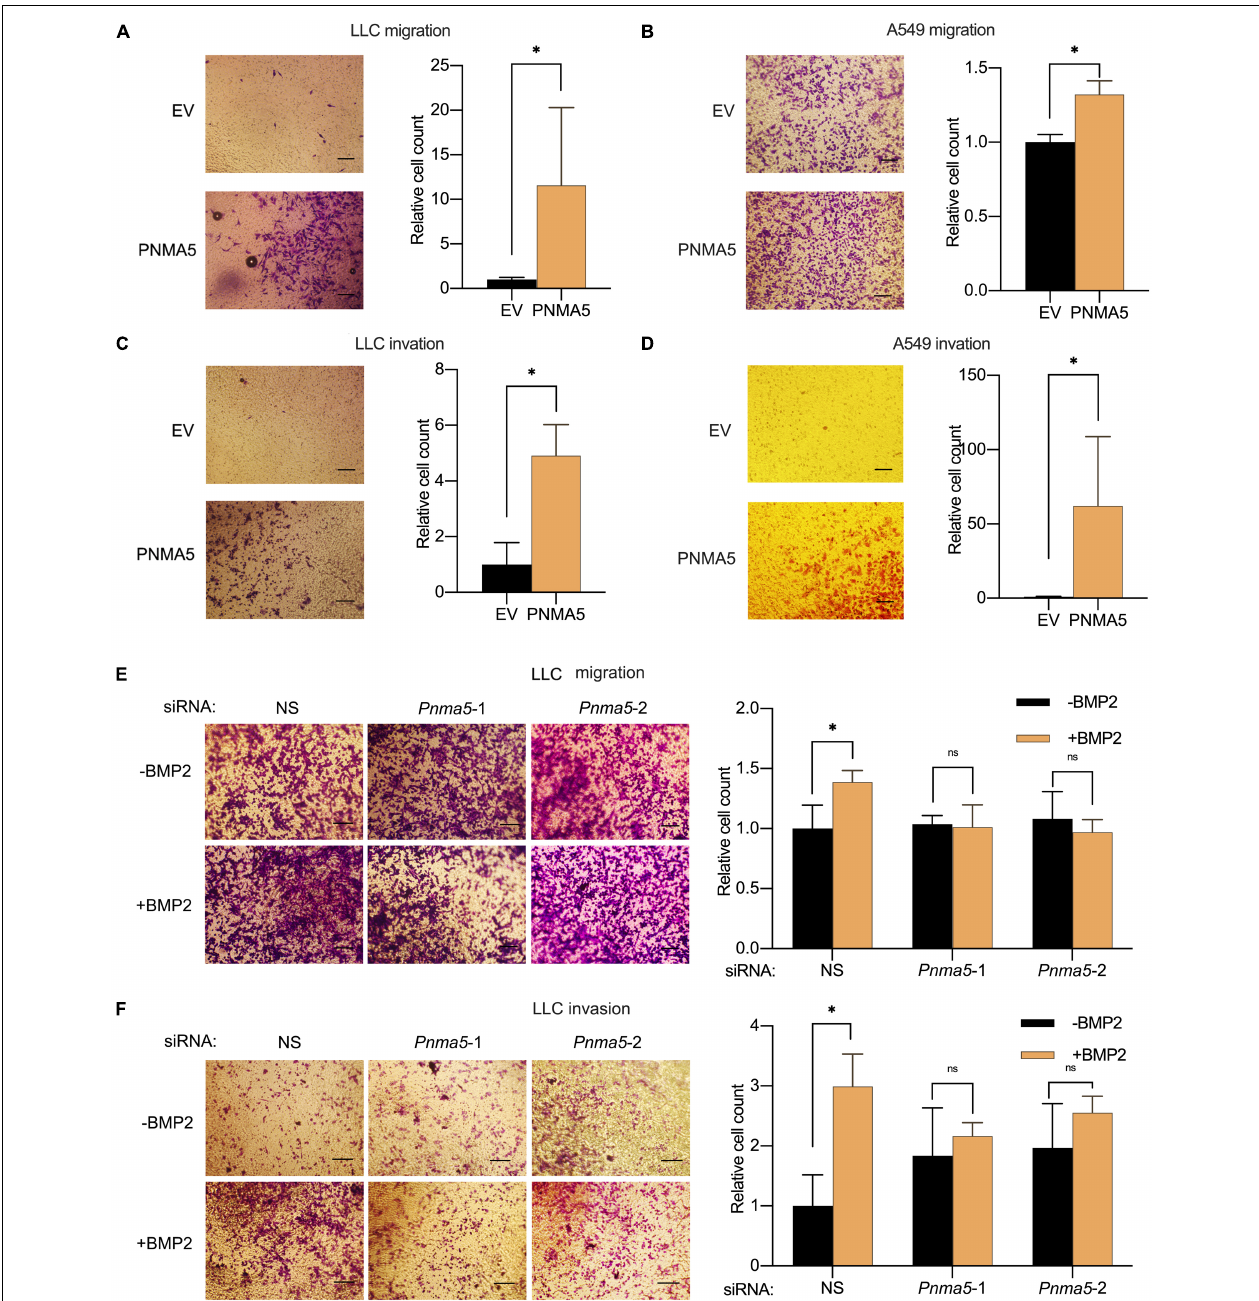
FIGURE 4 | BMP2 signaling induced the migration and invasion of NSCLC cells via PNMA5. (A,B) The 1 × 10 4 empty vector (EV) and PNMA5 overexpressed LLC (A) or A549 (B) cells were seeded and cultured in media without FBS on the upper layer of the Corning cell culture insert with polycarbonate membrane (Transwell@, 8.0 µ m pore size) for 24 h. The complete culture media were placed below the cell permeable membrane in the well plate. The migrating cells were stained with crystal violet and were taken photos. Average cell numbers of at least three fields were counted and shown on the right. * P < 0.05. (C,D) Corning cell culture insert with polycarbonate membrane (Transwell@, 8.0 µ m pore size) were pre-treated with 10:1 DMEM and matrigels (BD BioSciences). The 1 × 10 5 empty vector (EV) and PNMA5 overexpressed LLC (C) or A549 (D) cells were seeded and cultured in media without FBS on the upper layer of the pre-treated cell culture insert for 24 h. The complete culture media were placed below the cell permeable membrane in the well plate. The invading cells were stained with crystal violet and were taken photos. Average cell numbers of at least three fields were counted and shown on the right. * P < 0.05. (E) The 1 × 10 4 siRNA scrambler, siRNA Pnma5 -1 and siRNA Pnma5 -2 expressed LLC cells were treated as described in (A) . The migrating cells were stained with crystal violet and were taken photos. Average cell numbers of at least three fields were counted and shown on the right. * P < 0.05. (F) The 1 × 10 5 siRNA scrambler, siRNA Pnma5 -1 and siRNA Pnma5 -2 expressed LLC cells were treated as described in (C) . The invading cells were stained with crystal violet and were taken photos. Average cell numbers of at least three fields were counted and shown on the right. * P < 0.05.